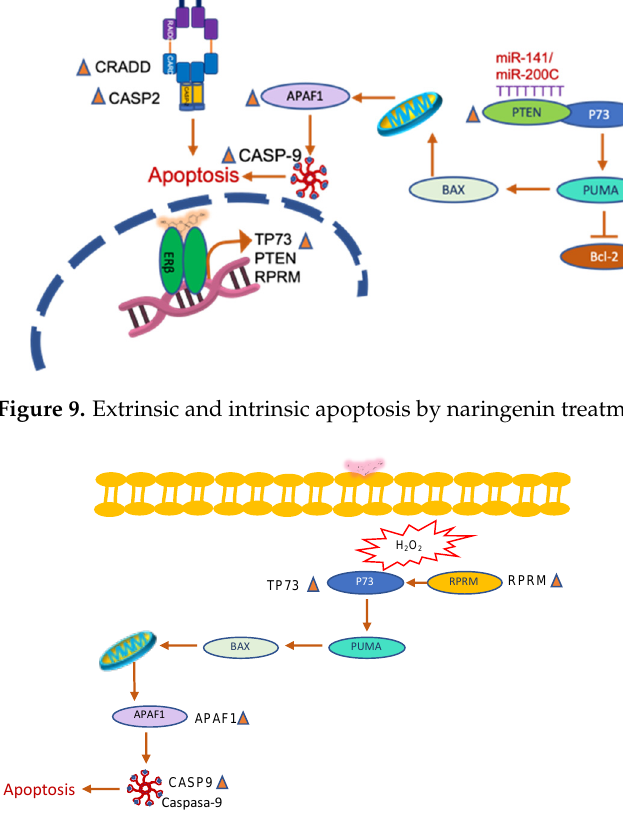
Figure 10. Intrinsic apoptosis by FEN treatment.